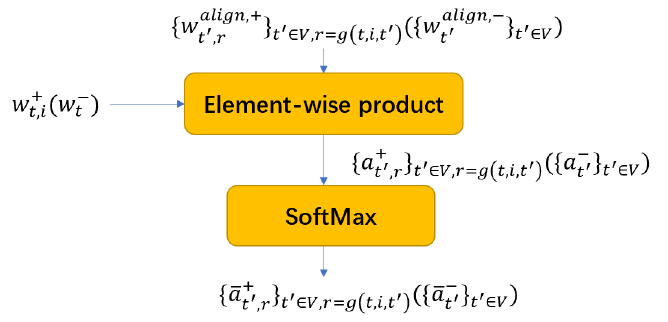
(cid:111) (cid:110) a + t (cid:48) , r t (cid:48) ∈ V , r = g ( t , i , t (cid:48) )